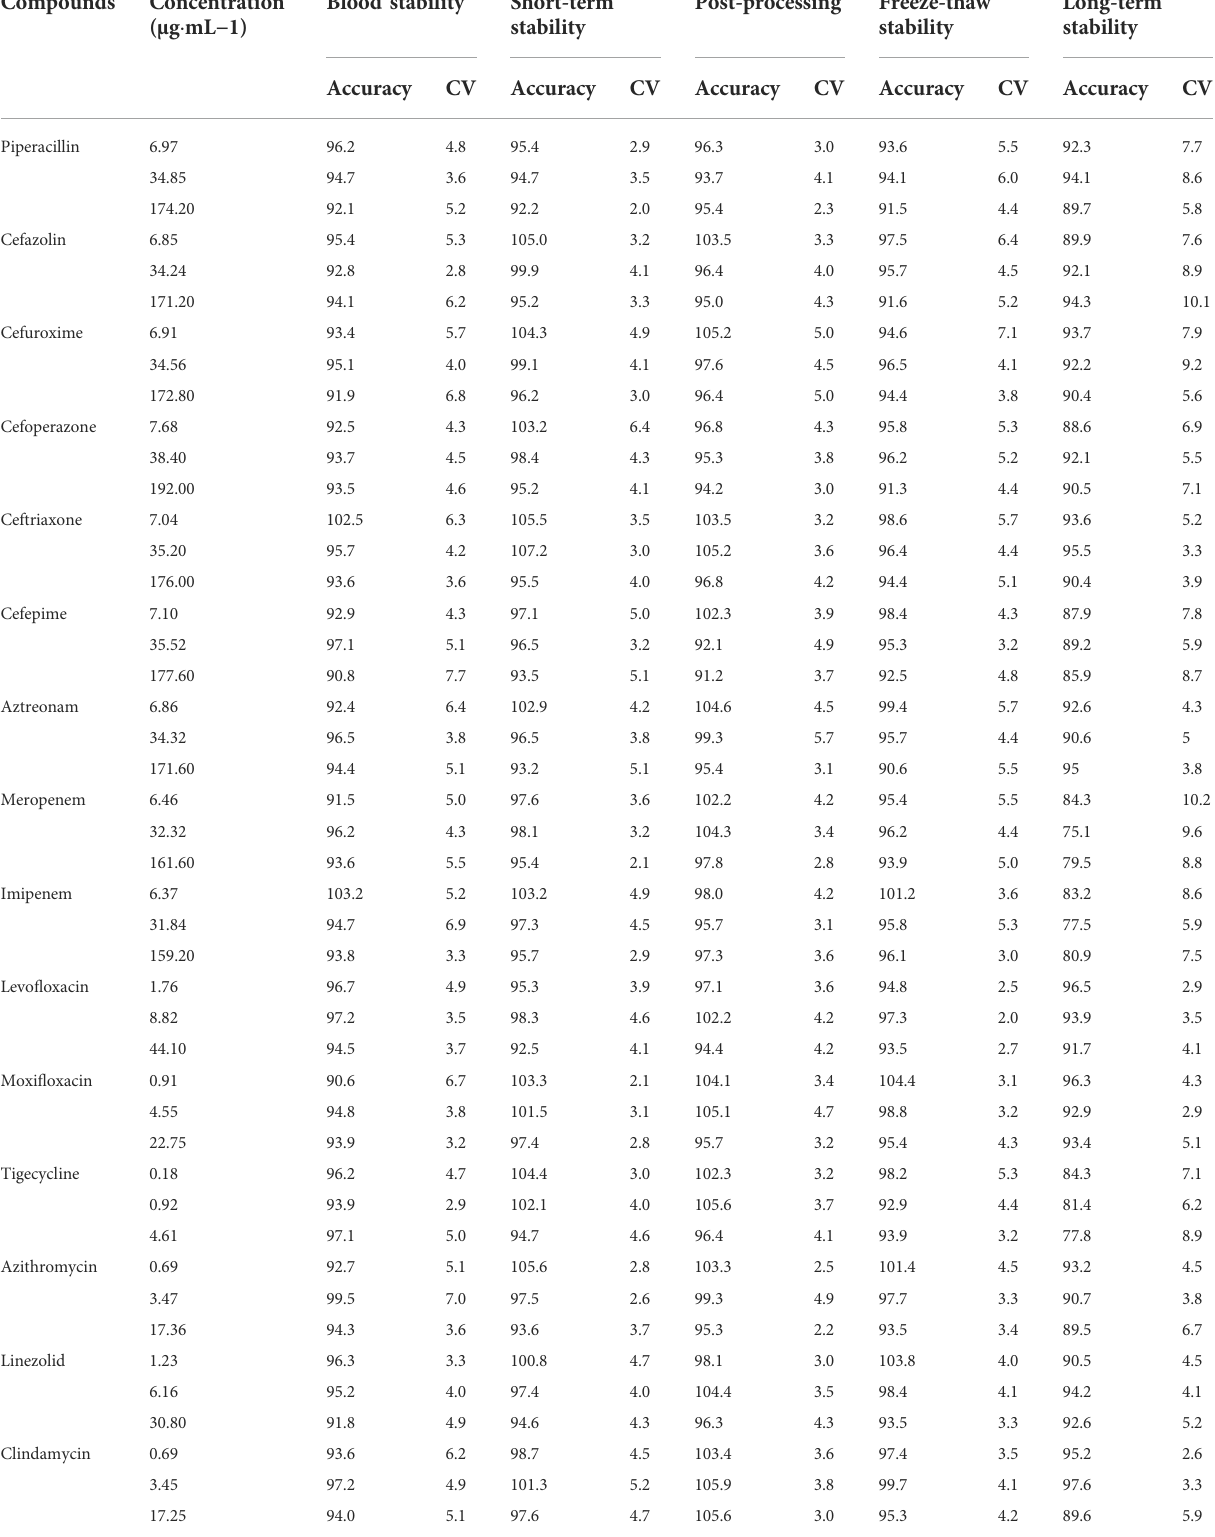
TABLE 6 Stability results of 18 antimicrobial agents in plasma at different storage conditions (% n = 6).